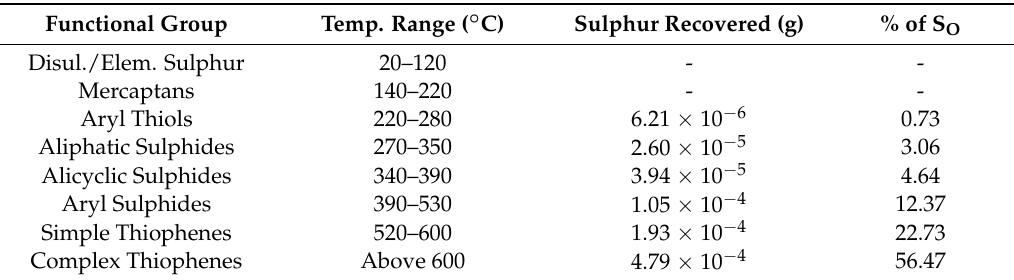
Table 4. Results for the TPR of untreated ollerton